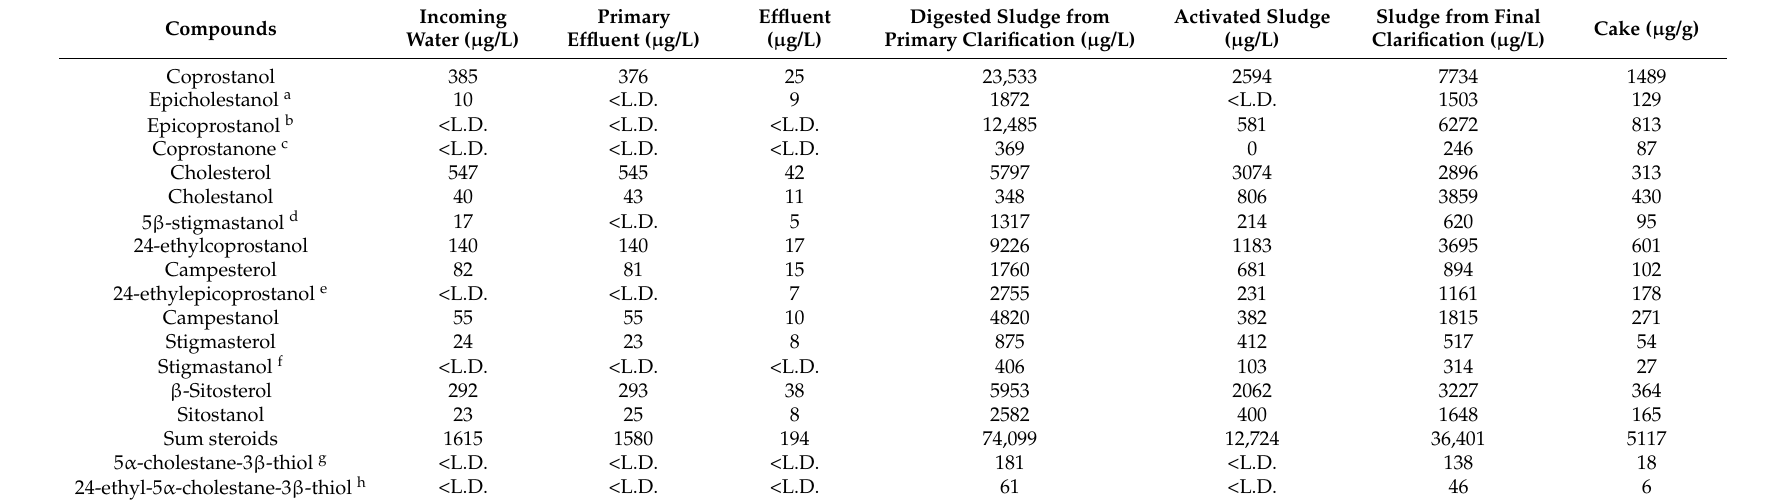
Activated Sludge Sludge from Final Cake ( µ g/g) ( µ g/L) Clarification ( µ g/L)